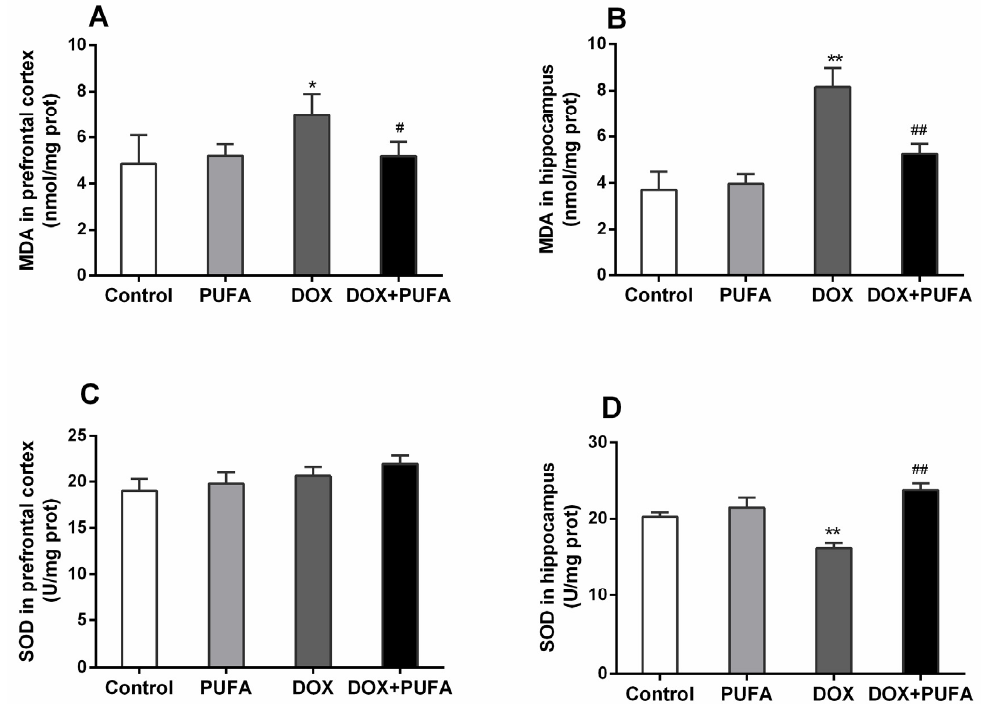
Figure 2. Effects of DOX and ω‐ 3 PUFAs on MDA and SOD in the prefrontal cortex and hippocampus. Data are expressed as means ± SD ( n = 6–7). * p < 0.05, ** p < 0.01 compared to control group. # p < 0.05, ## p < 0.01 compared to the DOX ‐ injected